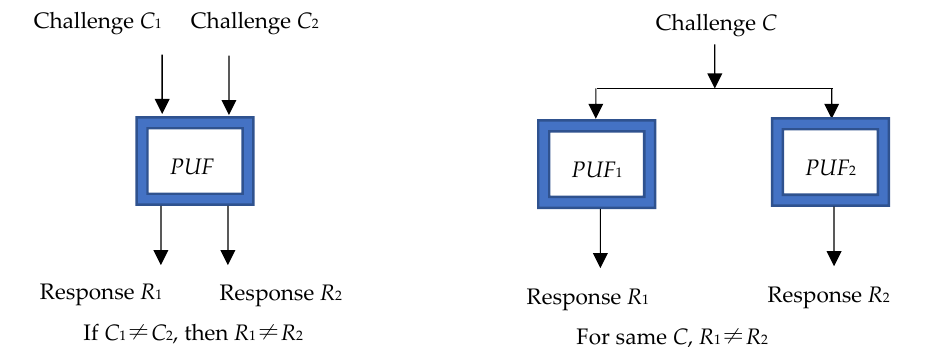
Figure 1. Challenge-response behavior of the silicon PUF.